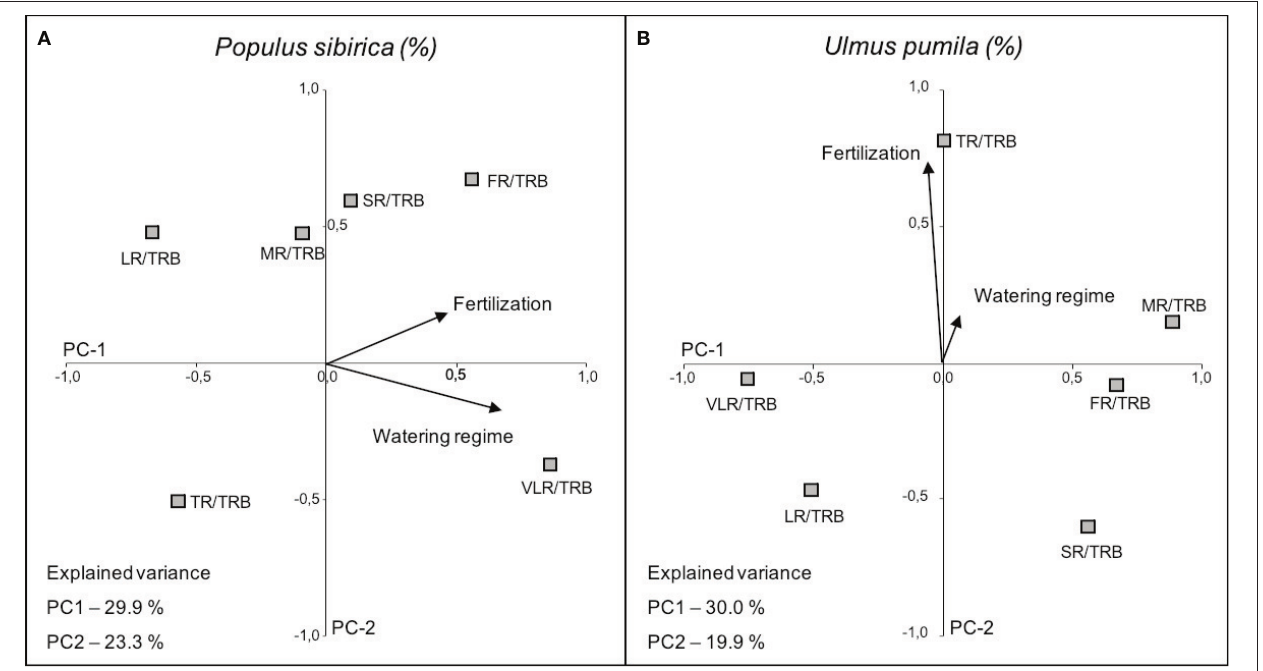
FIGURE 8 | Categorical Principal Component Analysis (CATPCA) biplot of P. sibirica (A) and U. pumila (B) indicating the percentage values of the ratio between different root classes and total root biomass projection in relation with watering regime and fertilization. Tightly clustered variables are positively related, while variables at different ends of the figure are negatively related. Arrows represents the mean influence magnitude for each